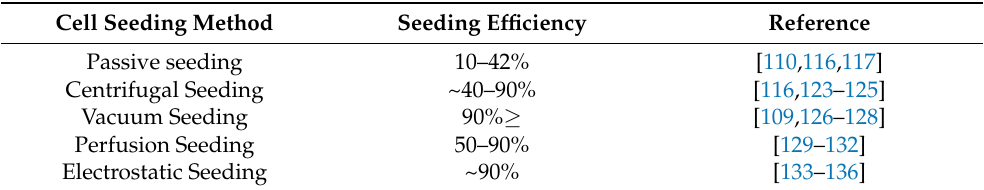
Table 3. Comparison of cell seeding efficiencies * between passive, dynamic (centrifugal, vacuum and perfusion) and electrostatic cell seeding